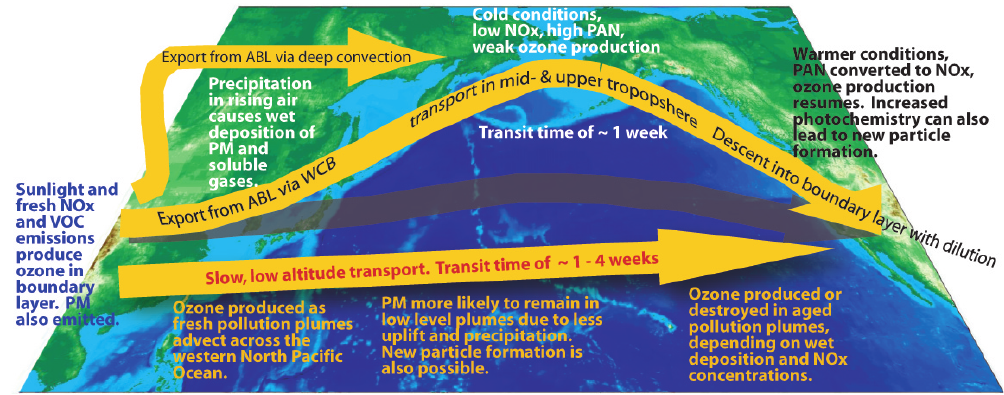
Fig. 1. General intercontinental transport processes. Blue text on the left applies to continental boundary layer processes, yellow/red text apples to low-level transport and black/white text applies to high-altitude transport (based upon HTAP, 2010; original figure courtesy of O.